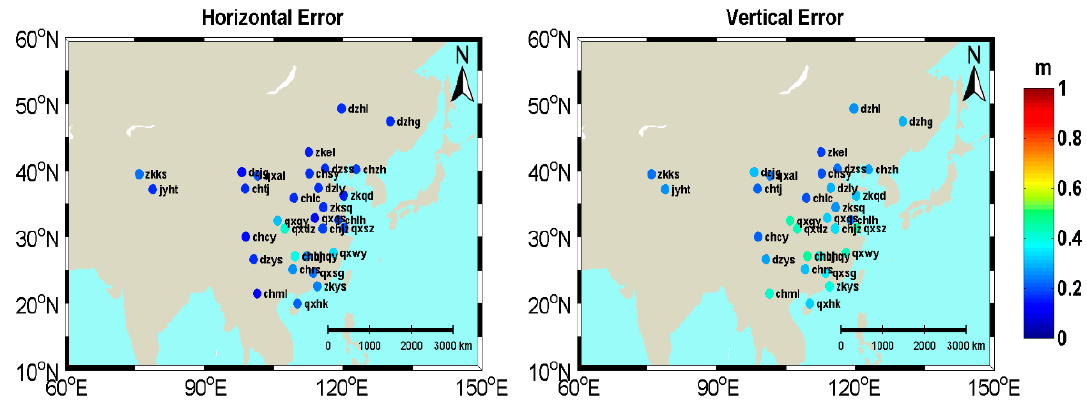
Figure 10. GPS real-time dual-frequency PPP positioning accuracy at the 95% confidence level.